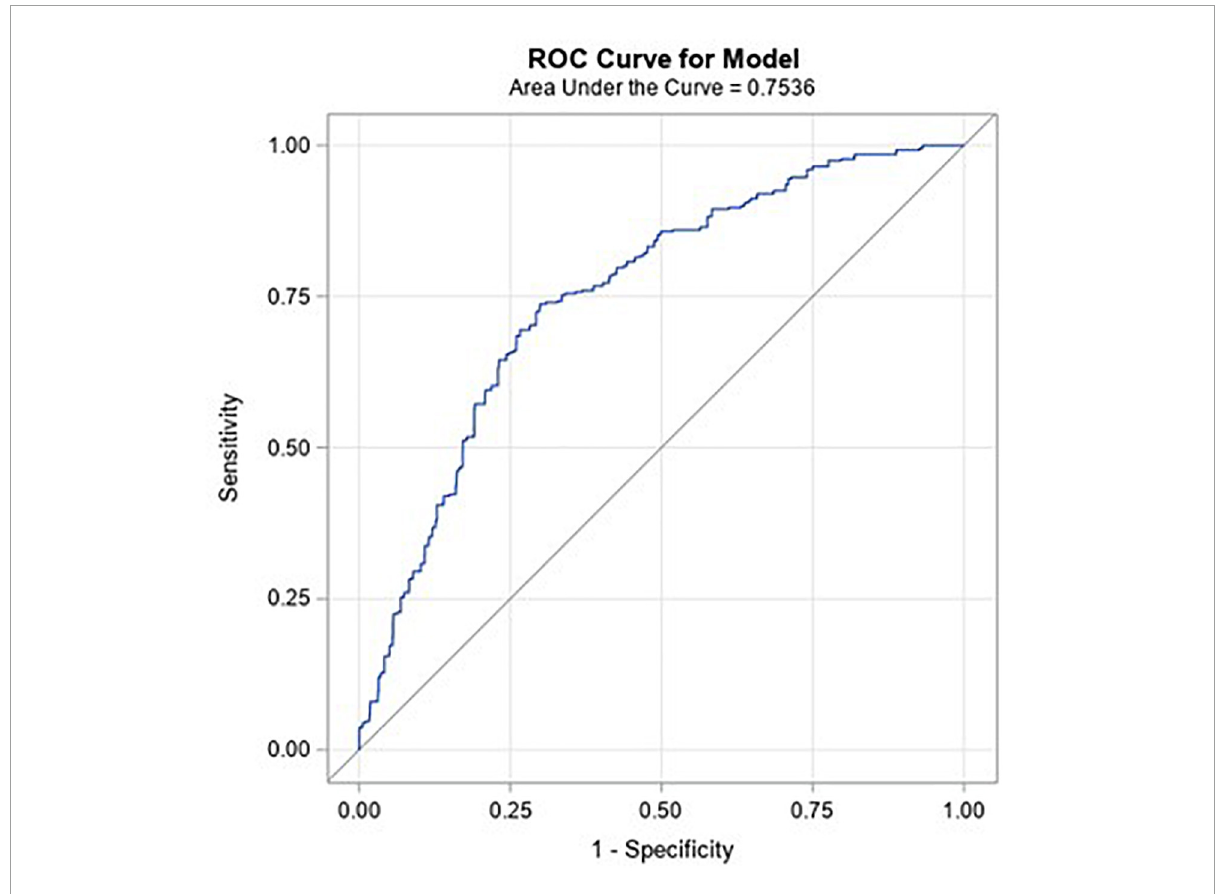
FIGURE7 ROC curve for the model against the validation population.